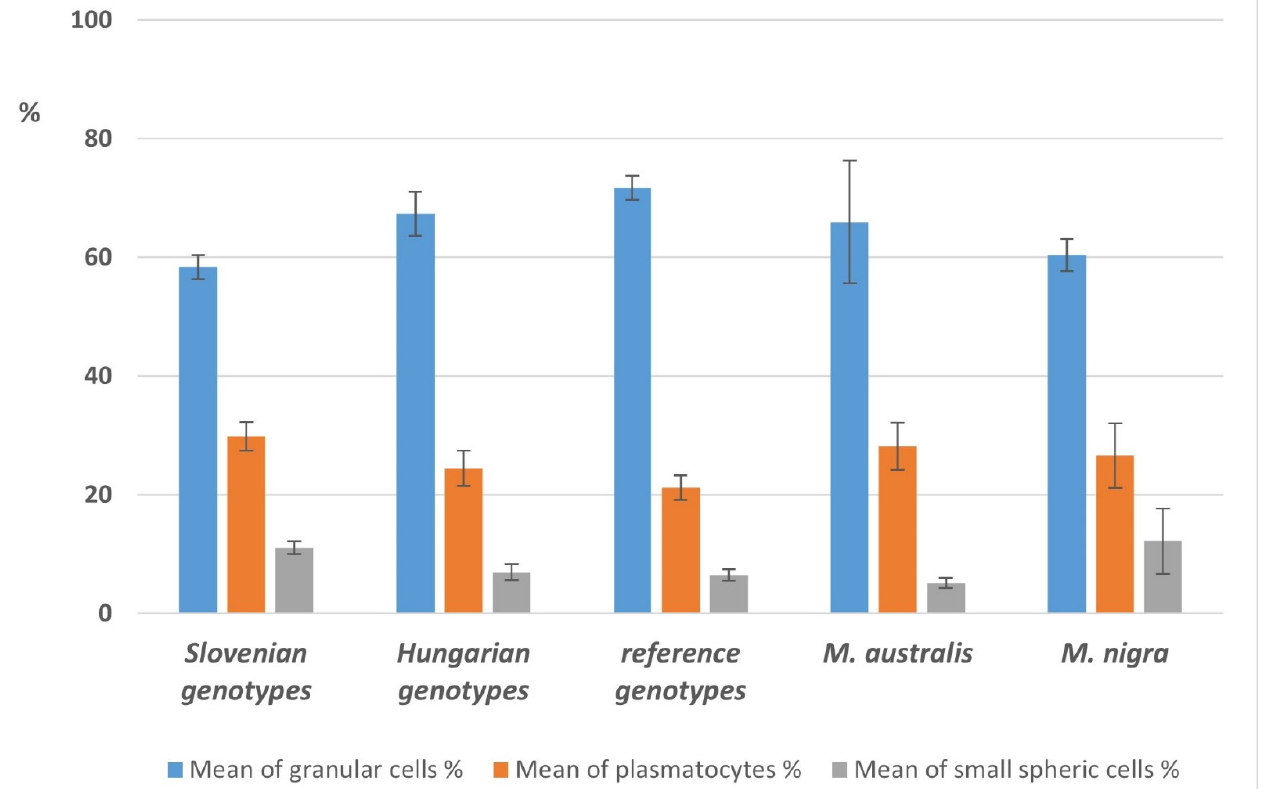
Figure 6. Differences in average haemocyte counts of larvae, fed with Slovenian, Hungarian, and reference sericultural genotypes and fruit varieties of mulberry trees.